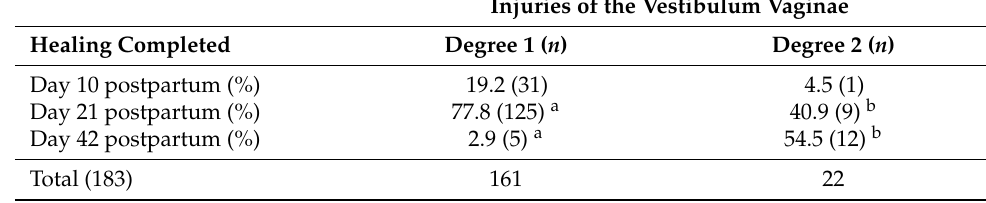
Table 2. Healing process of the mild and severe injuries in the vestibulum vaginae. Degrees of injuries of the vestibulum vaginae: degree 1: marked injuries <2 cm deep; degree 2: severe injuries ≥ 2 cm deep. Injuries of the Vestibulum Vaginae Healing Completed Degree 1 ( n ) Degree 2 ( n ) Day 10 postpartum